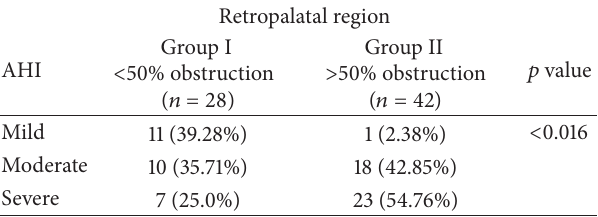
Table 7: AHI with Lateral pharyngeal wall collapse.